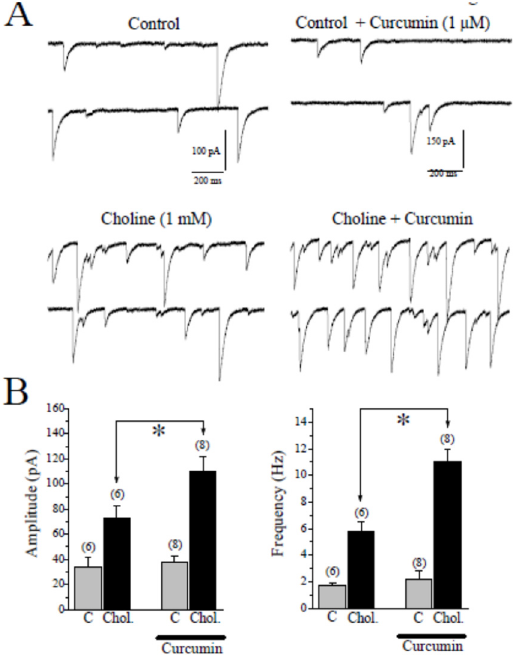
Figure 3. The effect of curcumin on choline-induced enhancement of GABAA receptor-mediated spontaneous synaptic events in CA1 pyramidal neurons. Whole-cell recordings were performed using CsCl-based electrode solution at a holding potential of − 70 mV. ( A ) On the left, the application of choline (2 mM) for 30 s increased the amplitudes and frequencies of spontaneous inhibitory postsynaptic currents (sIPSCs; n = 6). On the right, in another cell, choline-induced enhancements of sIPSCs were increased significantly after 2 min preincubation in curcumin (1 µM). ( B ) Summary of the effects of curcumin (1 µM) on choline-induced responses. The averaged amplitudes (on the left) and the frequencies (on the right) of sIPSCs were presented before (control C , gray bars) and after (black bars) choline (Chol. 2 mM) application. For comparison, the effect of choline on the GABAA receptor-mediated sIPSCs is shown in the absence and the presence of curcumin. Bars represent the means ± S.E. of six to eight experiments (* p < 0.05 vs. control; ANOVA). C, control; Chol., choline.